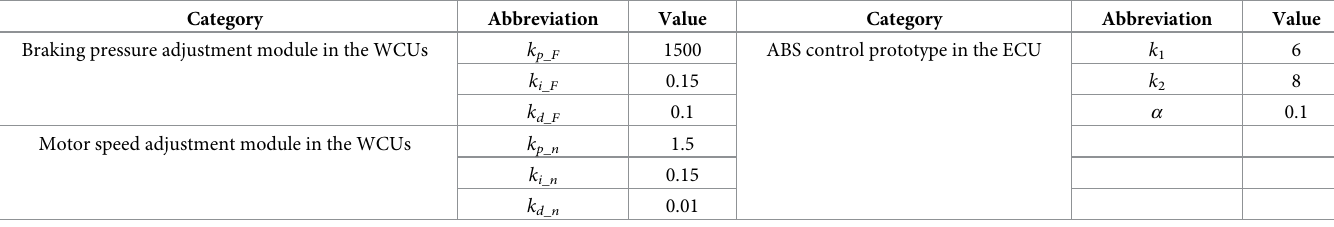
Table 3. The preliminary parameters of the control